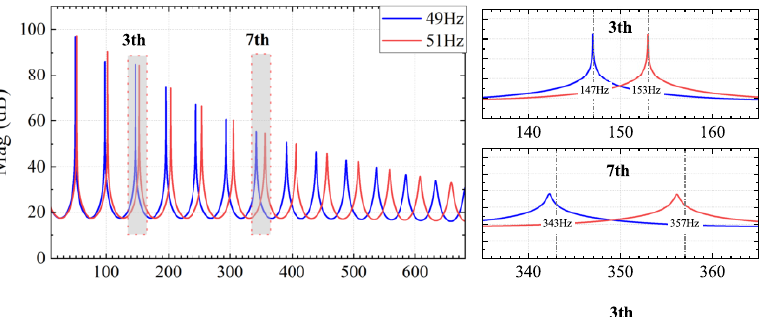
Figure 7. Proposed RC magnitude response: 10 Hz–680 Hz, 3rd harmonic, and 7th harmonic.